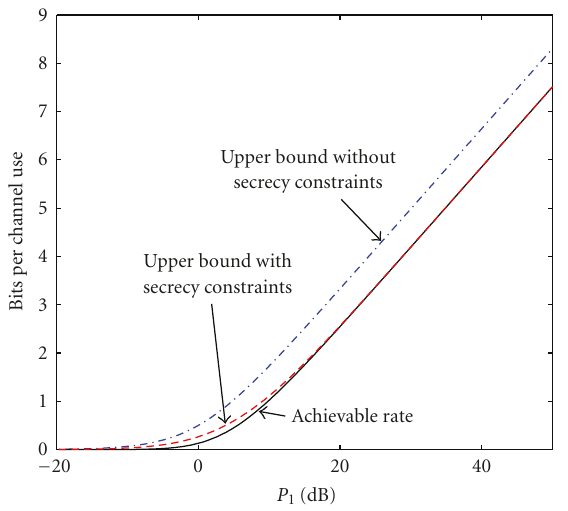
Figure 6: Secrecy Rate, P r → ∞ , P 2 = 0 . 5 P 1 , optimal α.